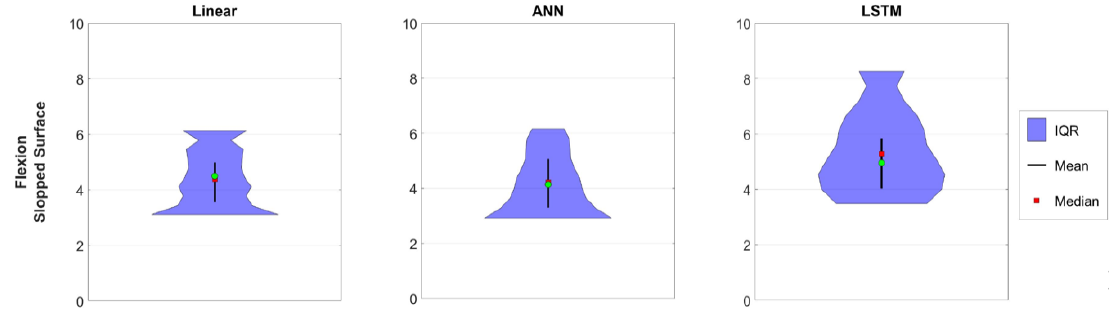
Figure 9. RMSE results of sloped surface experiments and flexion output for all participants excluding participant 4.